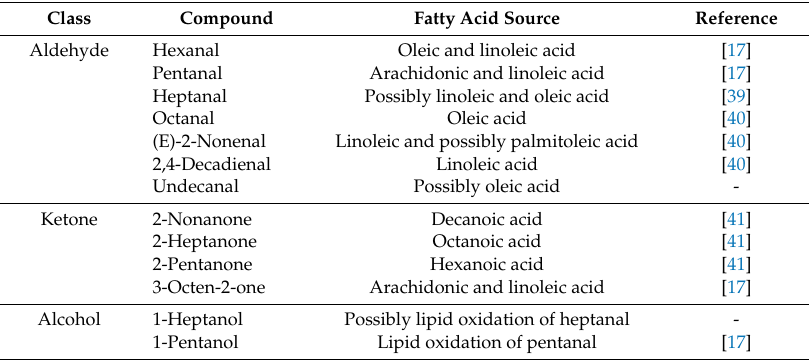
Table 2. The probable fatty acid sources for the 13 volatile compounds of